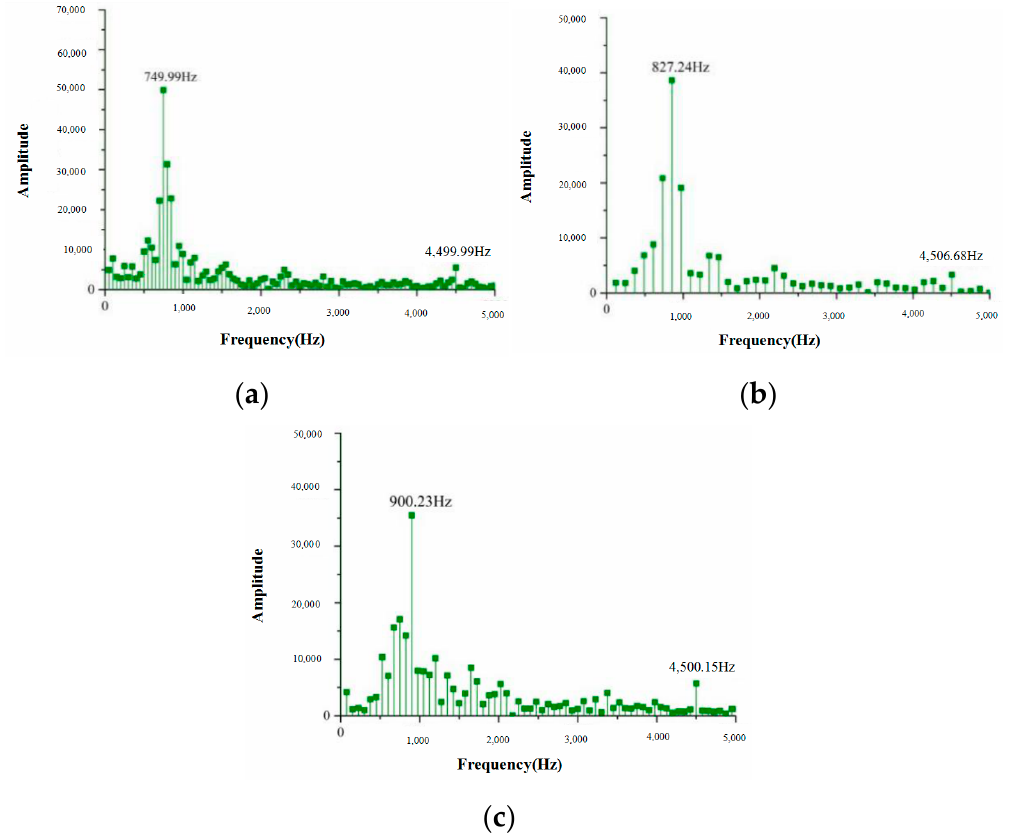
Figure 12. Frequency domain characteristic curve of S1 under different stall flow conditions: ( a ) the flowrate is 1.1 kg/s, ( b ) the flowrate is 0.9 kg/s, ( c ) the flowrate is 0.6 kg/s